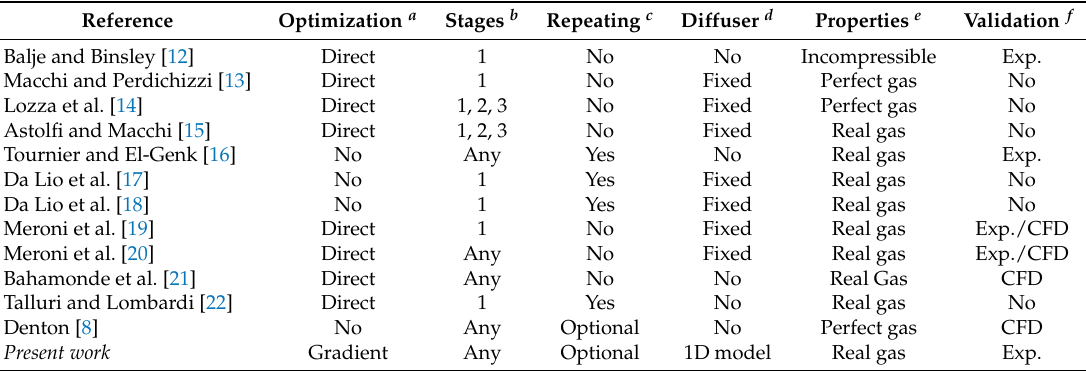
Table 1. Non-exhaustive survey of axial turbine mean-line